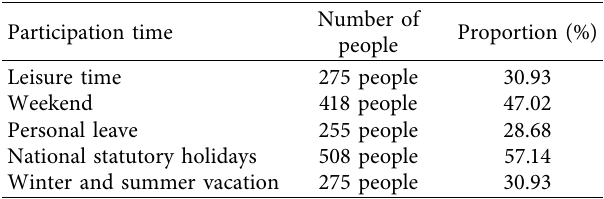
Table 2: Statistical analysis table of influencing factors of consumer participation time in sports